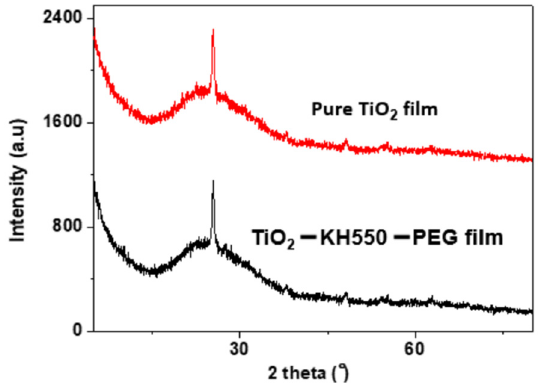
Figure 2. XRD pattern of pure TiO 2 film and modified TiO 2 ̶ KH550 ̶ PEG composite film.